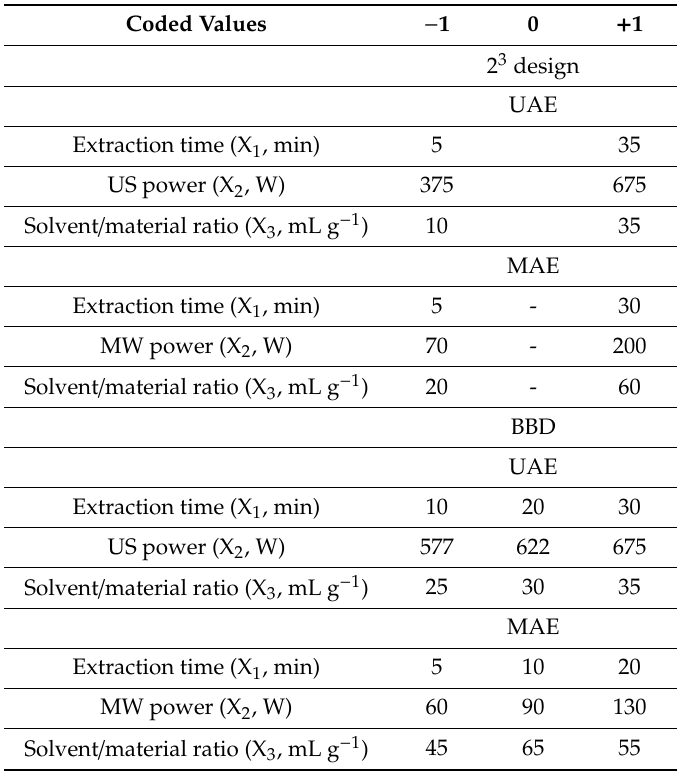
Table 4. Normalized and real values of UAE / MAE experimental factors for a two-level full factorial design (2 3 ) and Box–Behnken design (BBD) for apricot byproducts. Coded Values − 1 0 + 1 2 3 design UAE Extraction time (X 1 ,